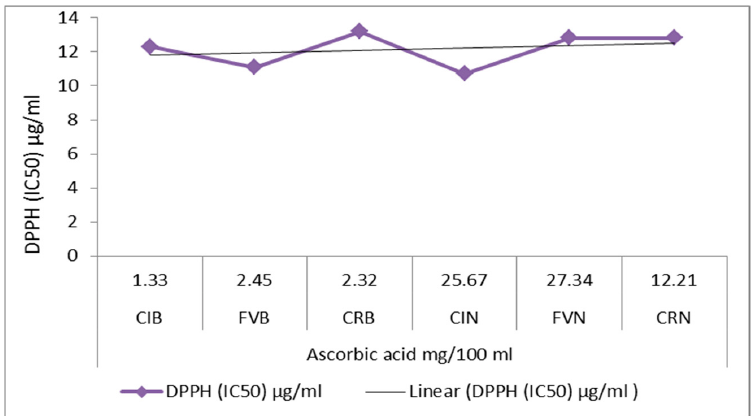
Figure 4. Quantification of ascorbic acid and antioxidant activity of bud and needle methanol extracts of Pinus mugo from three mountainous areas of Romania (Cindrel-Iujbea, F ă g ă ra ș -Vi ş tea, Cozia-Rotunda).